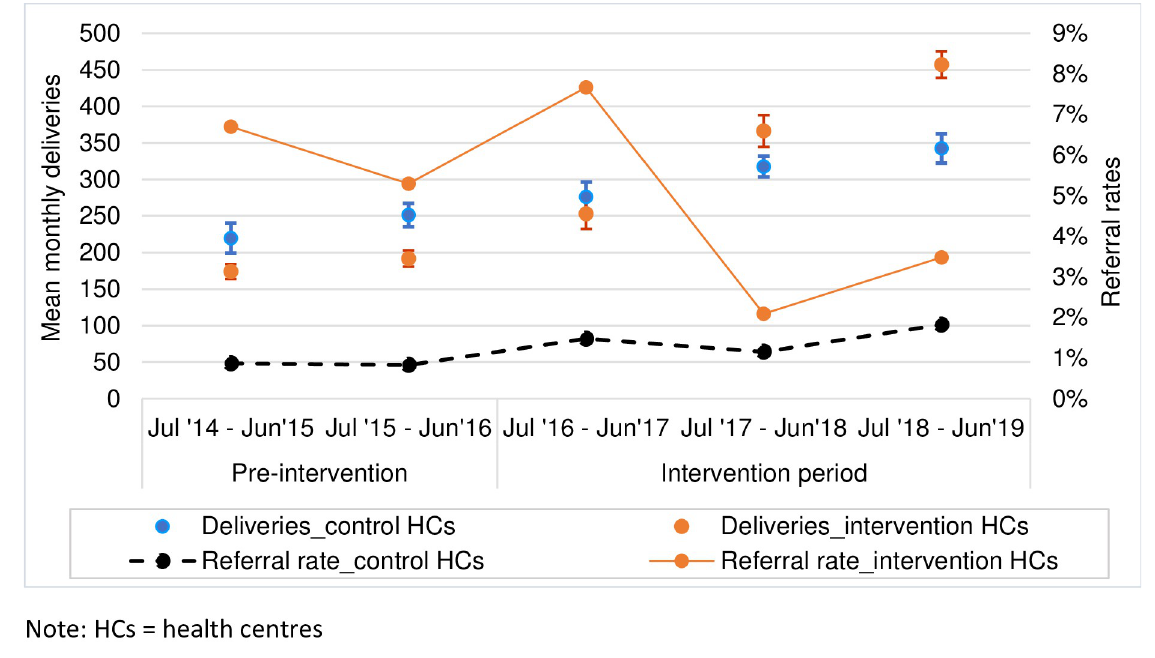
Fig 3. Trends in the mean monthly deliveries and referral rates before and during the intervention period.